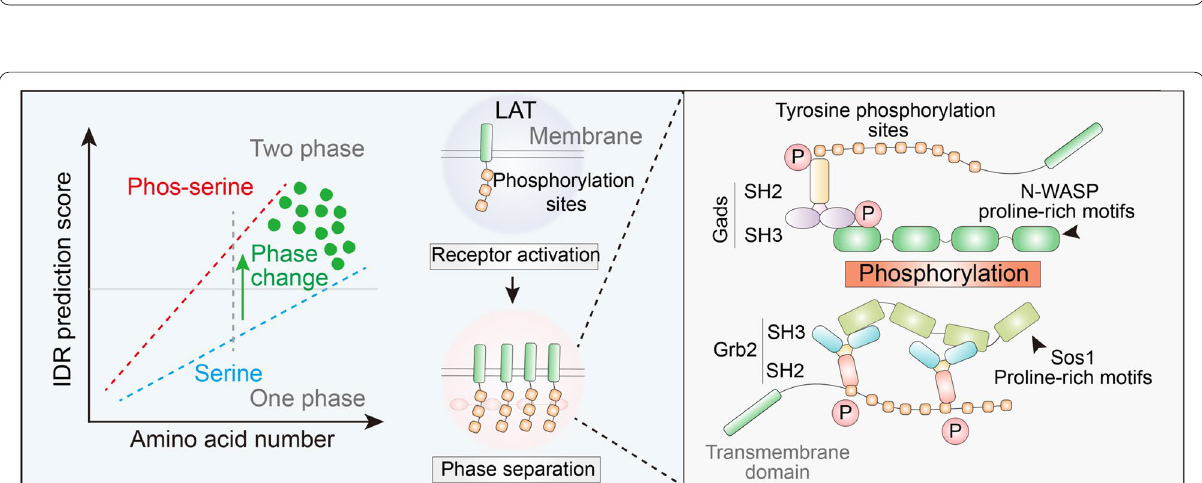
Fig. 5 Phosphorylation in LAT LLPS. Both phosphoserine and serine are basic parameters in IDR calculation. Activation and LLPS of LAT are related to phosphorylation-induced interactions among LAT, Gads, Grb2, and